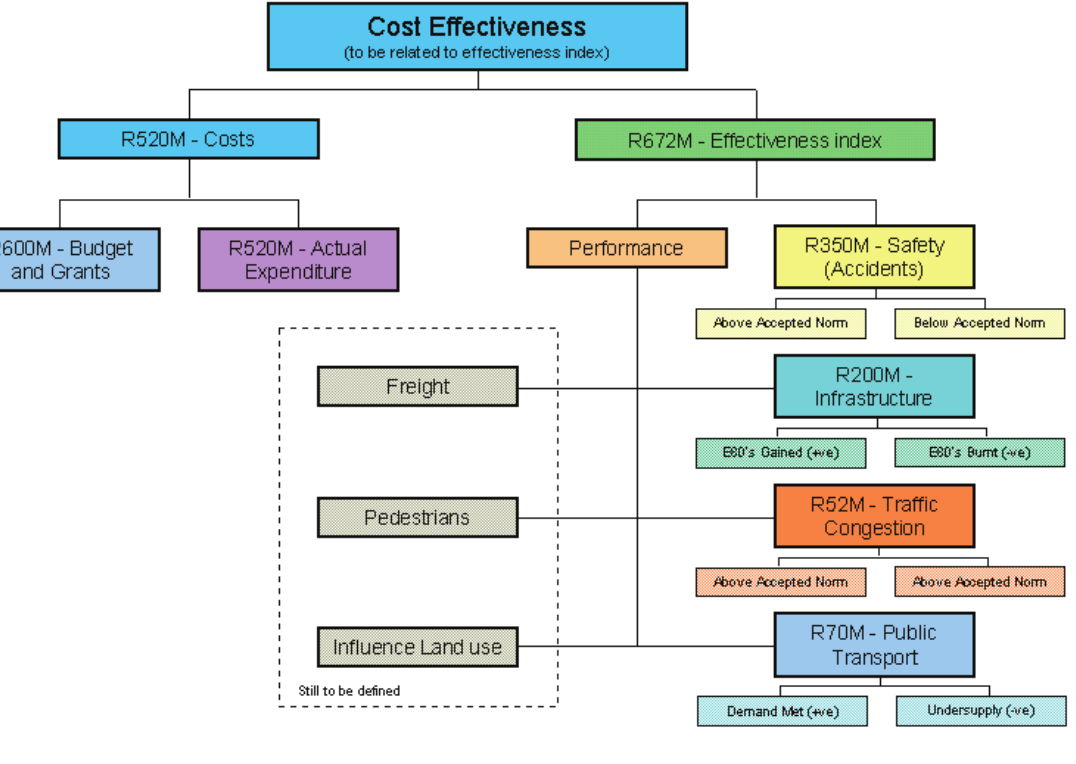
Figure 4.1: Cost-effectiveness of transportation (for demonstration purposes only) Figure 4.1: Page 1: Cost-effectiveness of transportation (for demonstration purposes